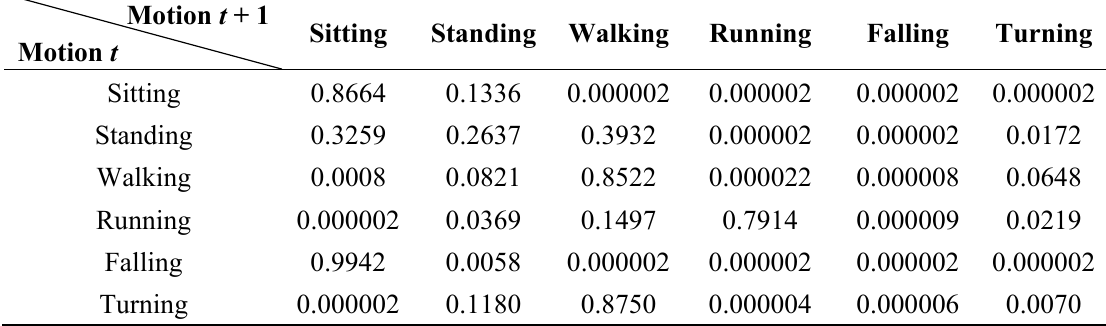
Table 3. Overall motion transition probability matrix in the office